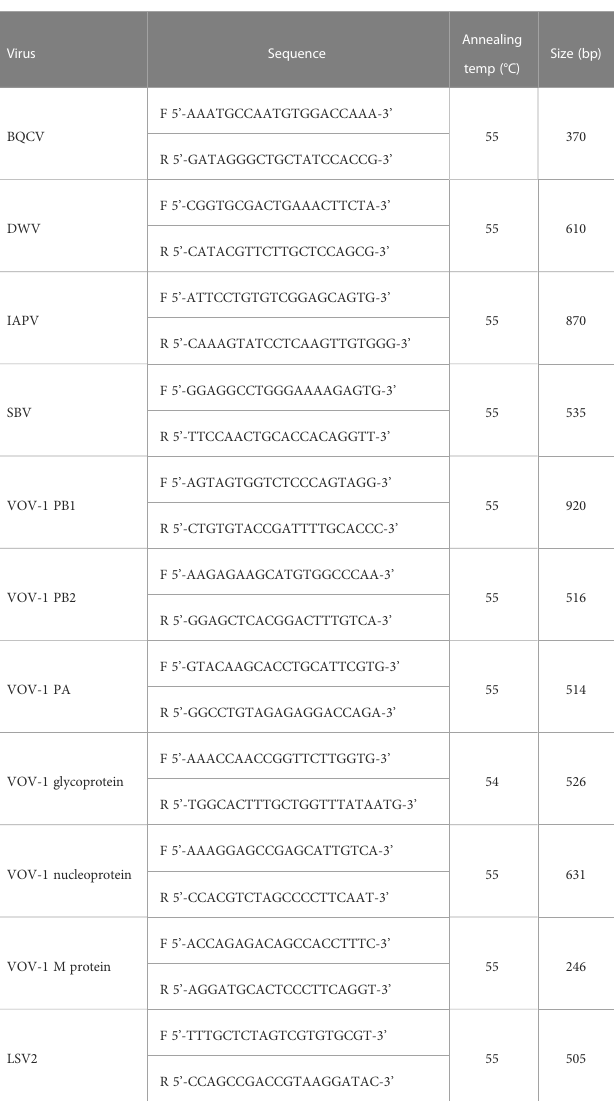
TABLE 1 List of primers used in this study.